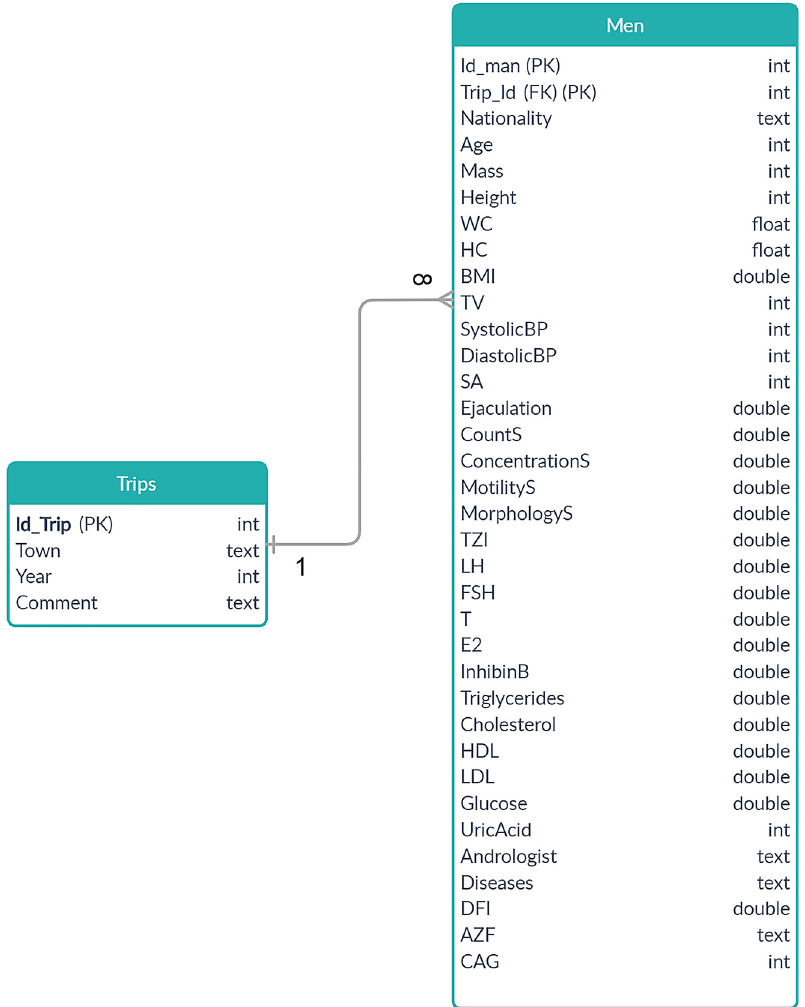
Figure 1: General scheme of the database «Reproductive potential of the male population of Russia» (ER-model of the database). The primary and foreign keys are marked PK and FK,